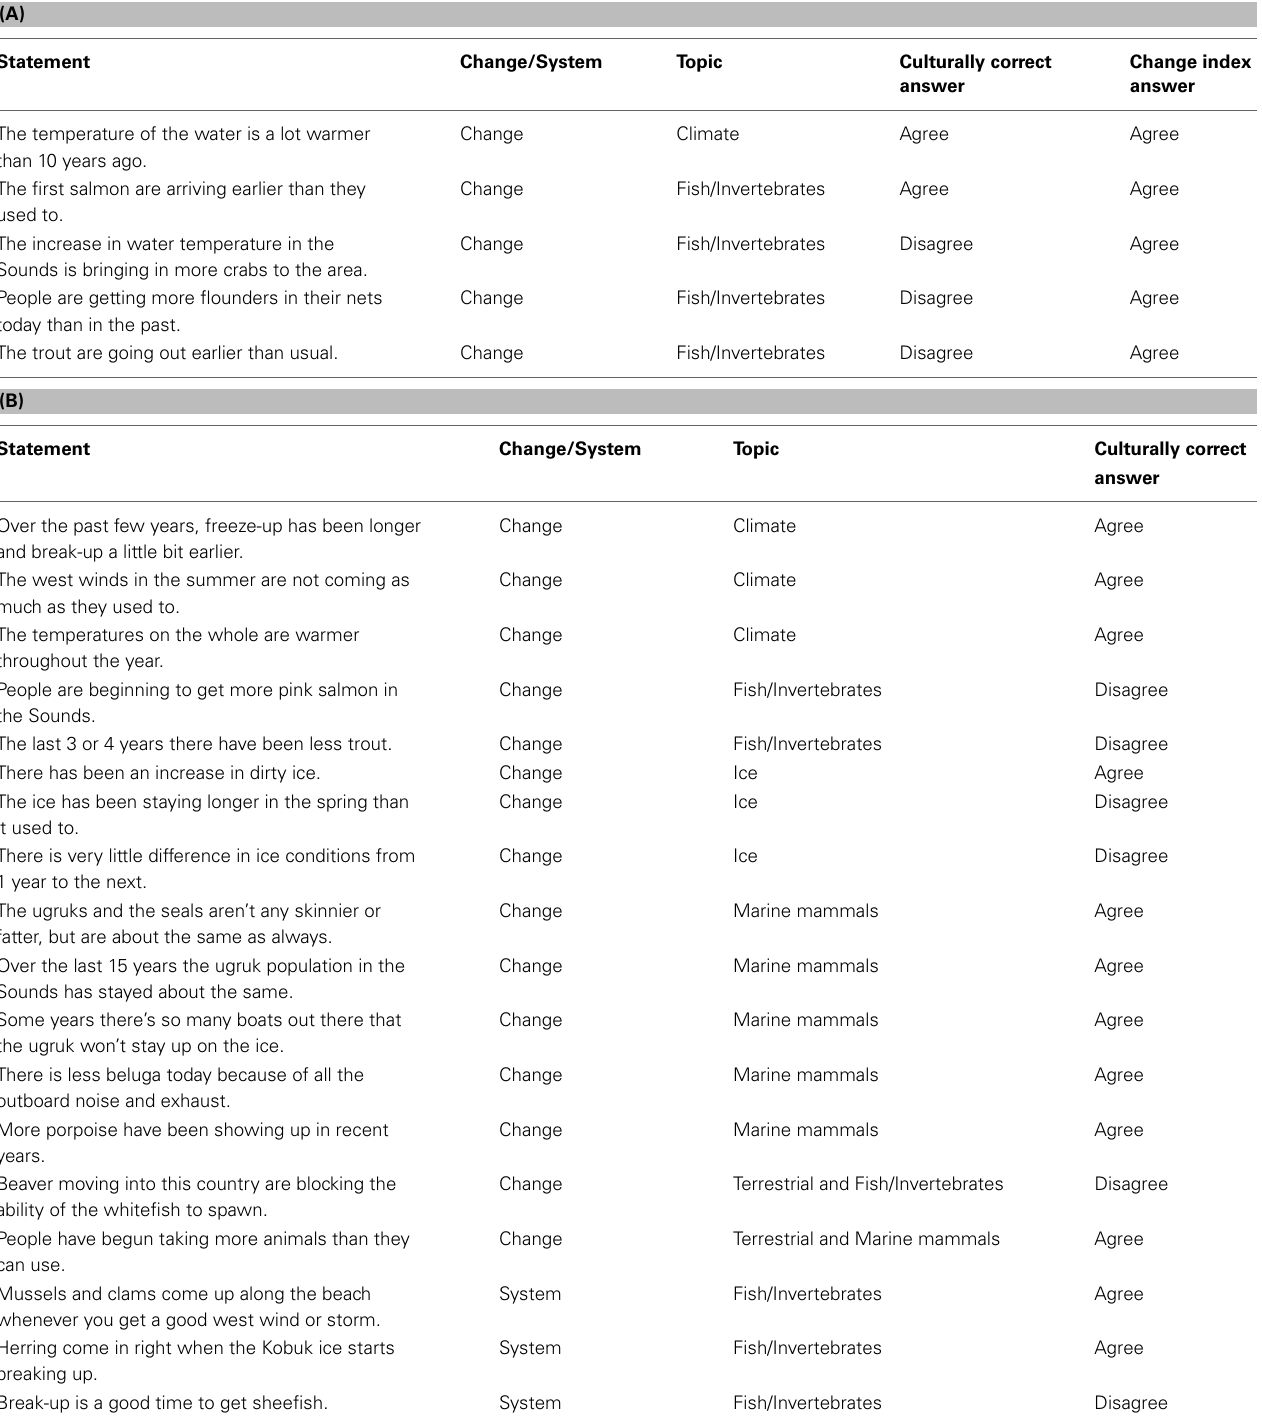
Table 1 | (A) The five propositions comprising the Climate Change Knowledge Index (CCKI) as derived from a factor analysis of all 35 propositions, the classification of the statement as either change related or system related, the statement topic, the culturally correct answer (as determined by the cultural consensus model using Bayesian modeling), and the answer for the index. (B) The remaining thirty agree/disagree propositions, the classification of the statement as either change related or system related, the statement topic, and the culturally correct answer (as determined by the cultural consensus model using Bayesian